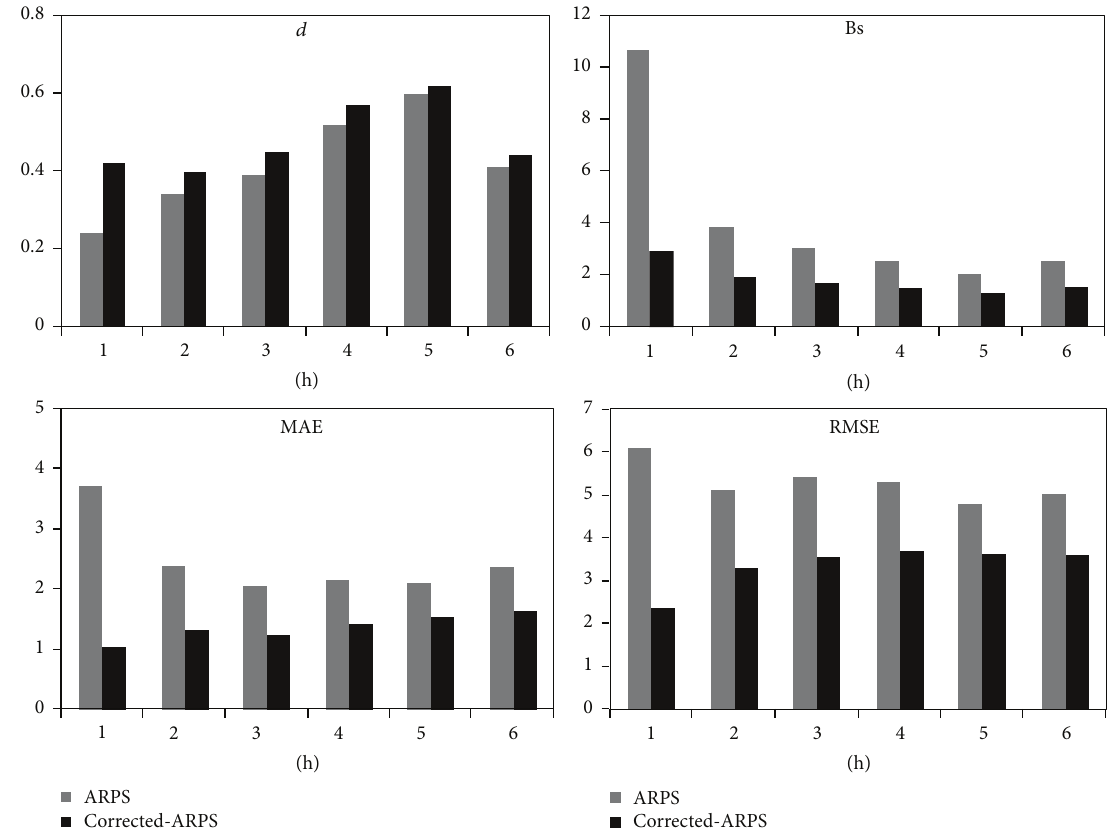
Figure 4: Quantitatively compare corrected ARPS precipitation forecasts with the original ARPS precipitation forecasts initialized at 1500 BJT on 24 June